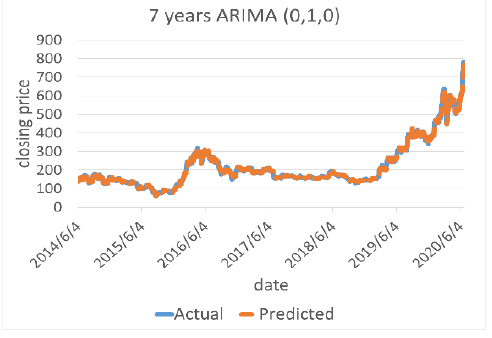
Figure 3. Prediction diagram of the optimal ARIMA model for 7, 3, 1, and 0.5 years for 3086 Wayi.